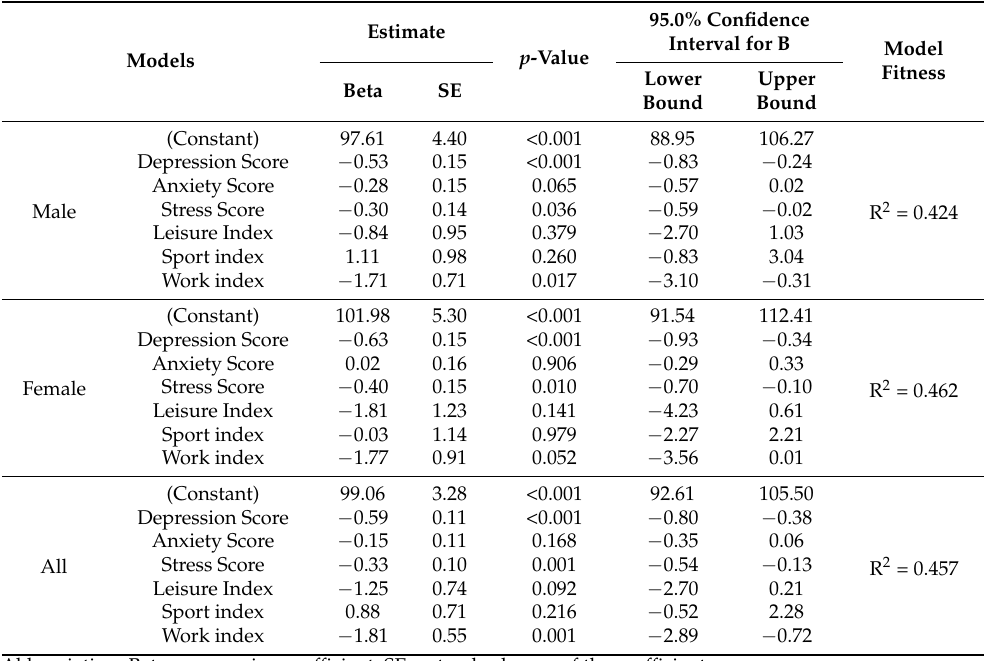
Table 5. Multiple linear regression models for the predictors of students’ quality of life.